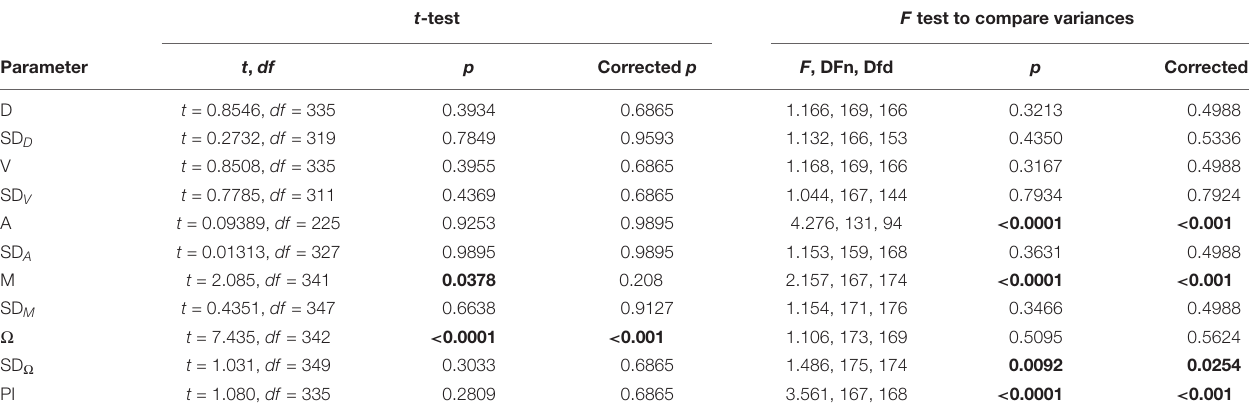
TABLE 2 | Statistical details for paired t -test.